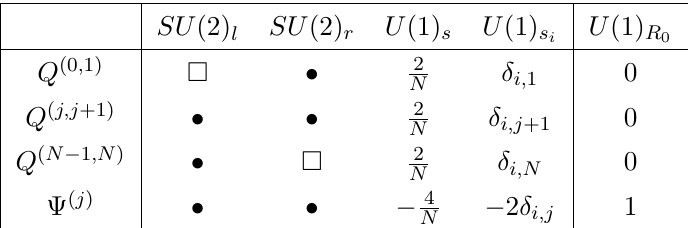
Table 6 . Transformation rules of the 2 d matter fields coming from the dimensional reduction of theory T 4d after the reparametrization. A